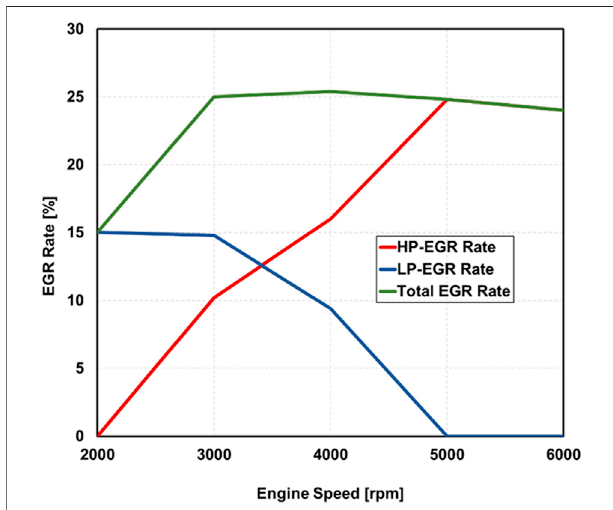
FIGURE 3 | Blended EGR from the HP-EGR and LP-EGR